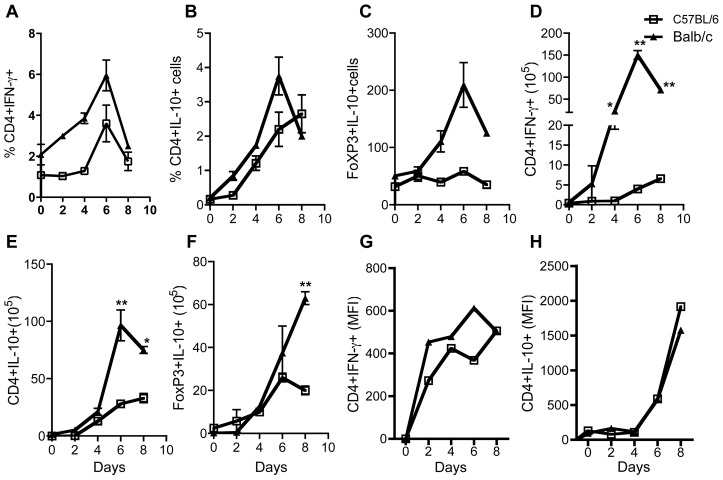
Differential cytokine profile in T. congolense-infected C57BL/6 and BALB/c mice.Female C57BL/6 and BALB/c mice infected with T. congolense were sacrificed at different time points as indicated and the percentage of CD4+IFN-γ + (A), CD4+IL-10+ T cells (B), and FoxP3+IL-10+ (C) T cells were determined directly ex vivo by flow cytometry. In addition, the absolute numbers of CD4+IFN-γ+ (D), CD4+IL-10+ (E) and FoxP3+IL-10+ (F), mean flourescence intensity for CD4+IFN-γ (G) and CD4+IL-10+(H) and T cells in the splenocytes were also determined from the flow cytometric and cell count values. Results presented are representative of 3 independent experiments (n = 3–4 mice per group) with similar results. (*, p<0.05; **, p<0.01).